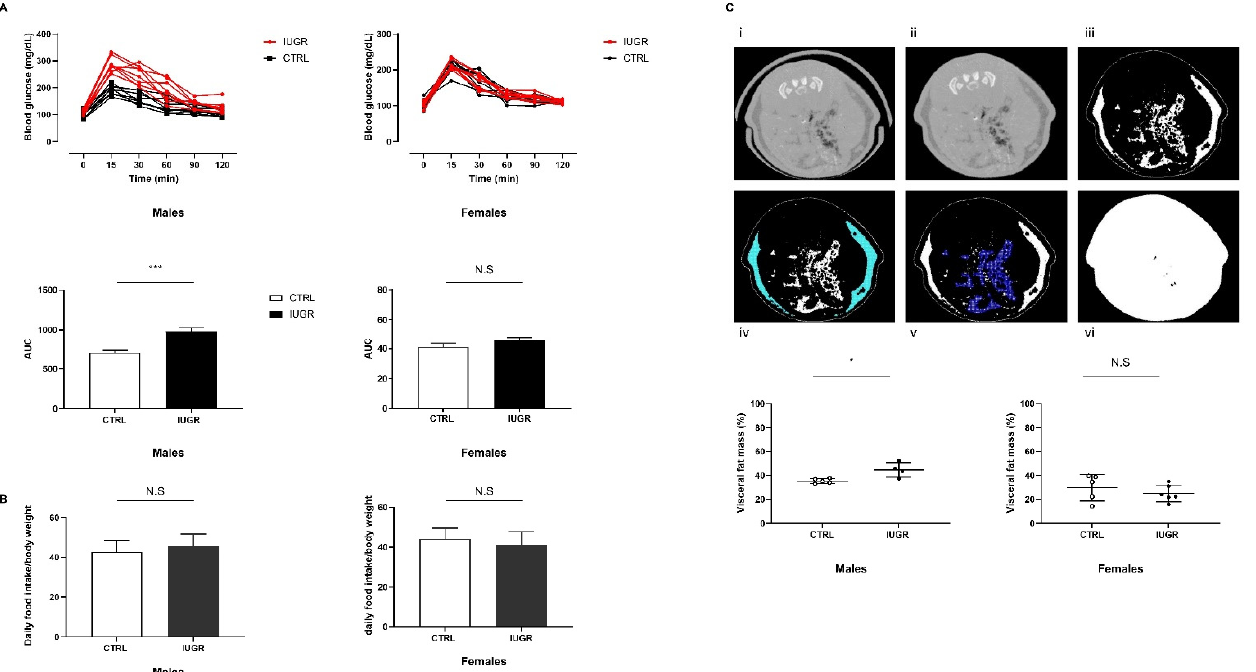
Figure 1 . Metabolic explorations in IUGR and CTRL males and females at 6 months of age. AUC after glucose challenge ( A ) and daily food intake ( B ) was determined in n = 8 animals/group/sex. VAT measurement was performed in males and females ( C ); CT of a slice passing through the 6th lumbar vertebra before (i) and after (ii) rat holding structure removal. TAT segmentation expressed in white (iii) and SAT demarcation (iv). VAT scattered between the organs (v) expressed as a total slice (vi) percentage. n = 4–6 animals/group/sex. * p < 0.05; *** p < 0.001; N.S: not significant.